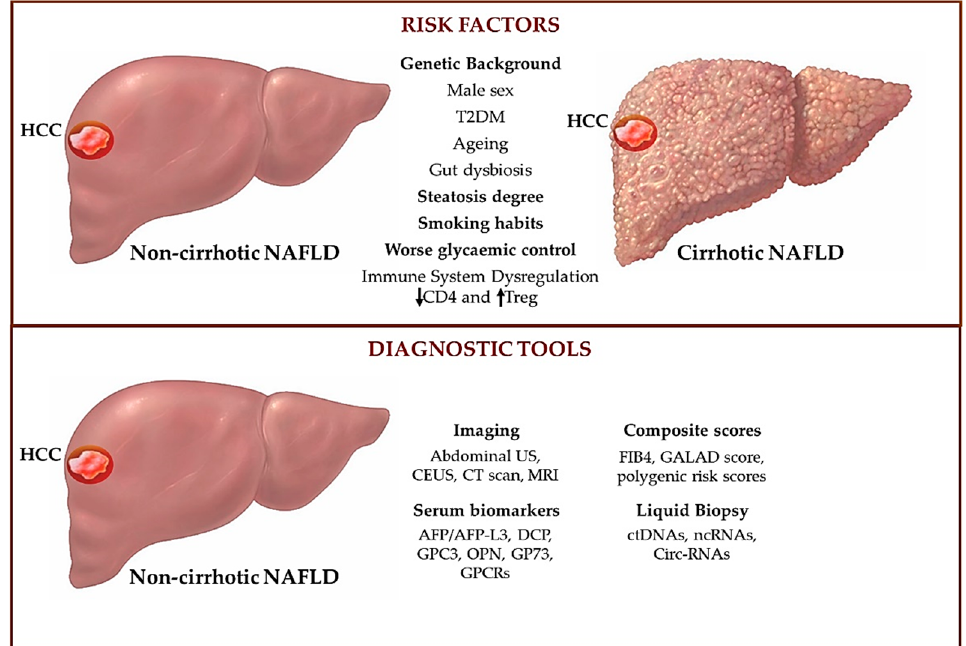
Figure 1. Clinical and molecular risk factors associated with the development of HCC in NAFLD patients with or without cirrhosis (upper panel) and current and future diagnostic tools for the diagnosis of HCC in non-cirrhotic NAFLD patients (lower panel). Genetic background, steatosis degree, smoking habits, and worse glycemic control are marked in bold, since these factors more specifically trigger HCC onset in non-cirrhotic NAFLD patients. ↓ : downregulation; ↑ : upregulation. HCC: hepatocellular carcinoma; NAFLD: non-alcoholic fatty liver disease; T2DM: type 2 diabetes mellitus; US: ultrasound, CEUS: contrast-enhanced ultrasound; CT: computed tomography; MRI: magnetic resonance imaging; AFP: alpha-fetoprotein; DCP: des-gamma carboxyprothrombin; OPN: osteopontin; GP73: Golgi protein-73; GPCRs: G protein-coupled receptors; FIB4: fibrosis-4 index; PRS: polygenic risk score; ctDNAs: cell-circulating tumor DNAs; and Circ-RNAs: circular non- coding RNAs.